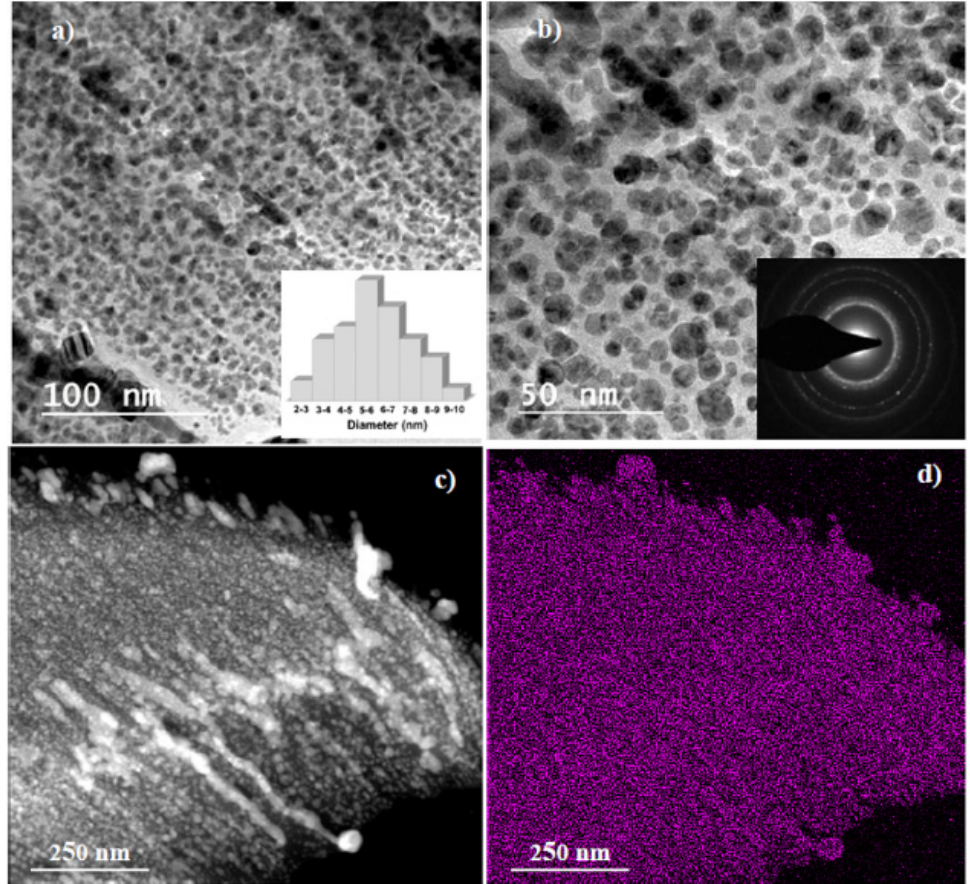
Figure 2. AgNPs film visualised with TEM ( a , b ). Inset ( a ) demonstrates size distribution and inset ( b ) is the electron diffraction pattern; Scanning energy dispersive x-ray spectroscopy mapping with ( c ) STEM image and ( d ) silver elemental mapping. Reprinted with permission from ACS Appl.